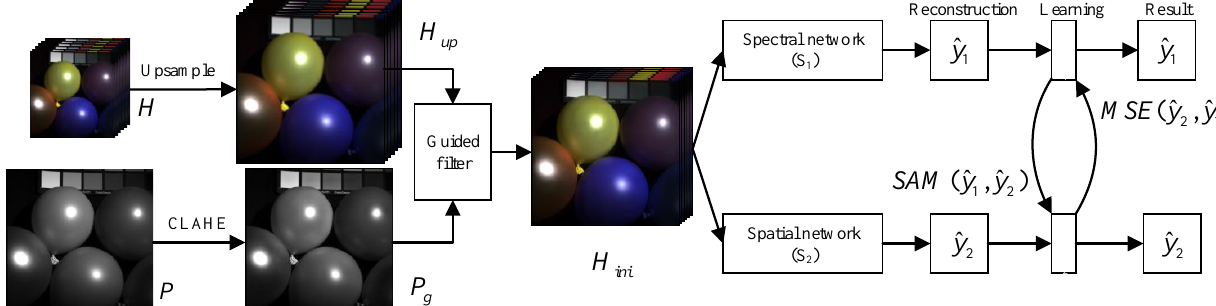
Figure 1. The structure of the proposed SSML